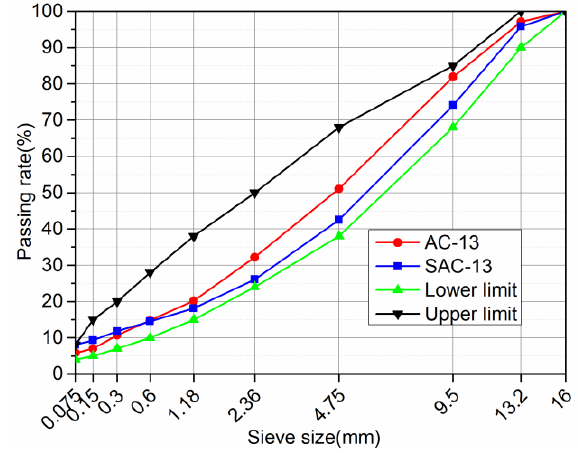
Figure 2. Gradation curves of AC-13 and SAC-13.